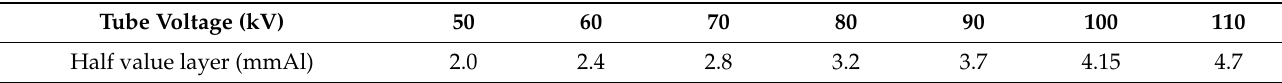
Table 1. Fluoroscopic X-ray tube voltage and half value